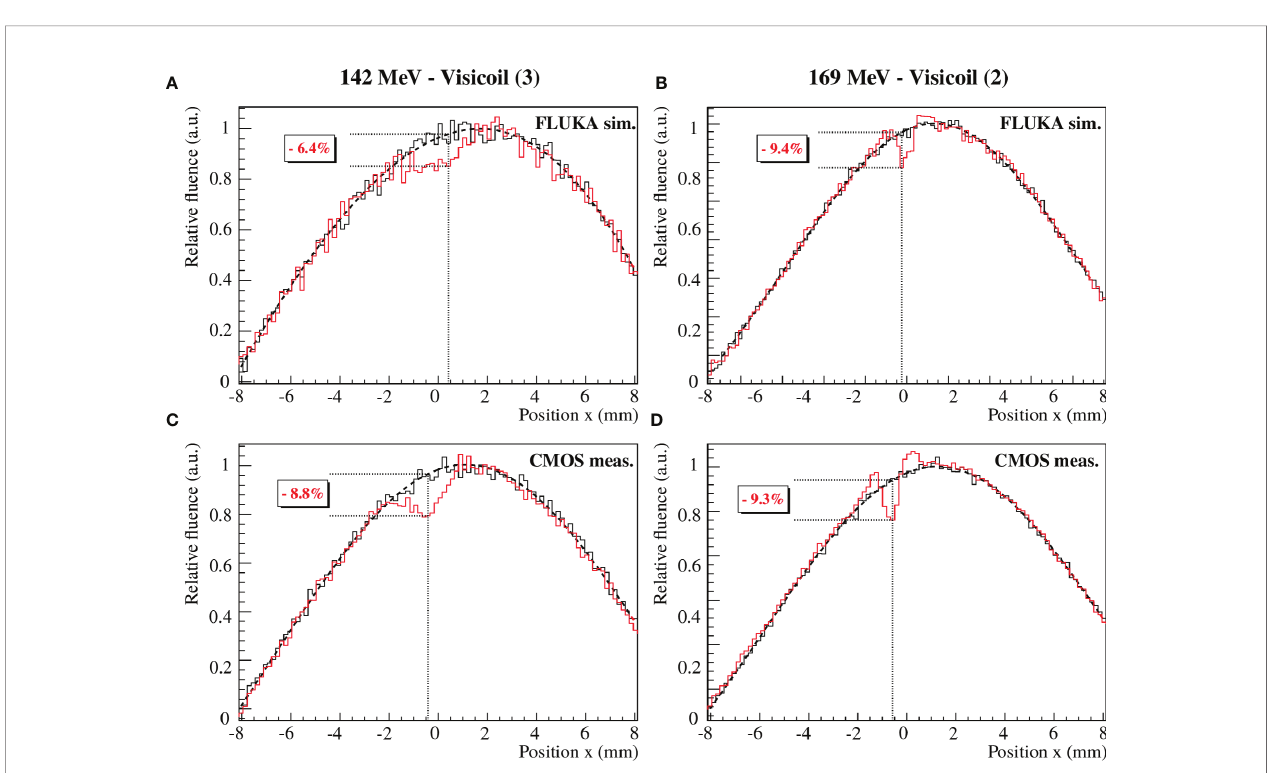
FIGURE 11 | Beam pro fi le comparison between the FLUKA simulations (A, B) and the CMOS measurements (C, D) for 142MeV protons passing through the Visicoil (3) (A, C) and 169MeV protons passing through the Visicoil (2) (B, D) . The red and black lines show the beam pro fi les with and without marker,